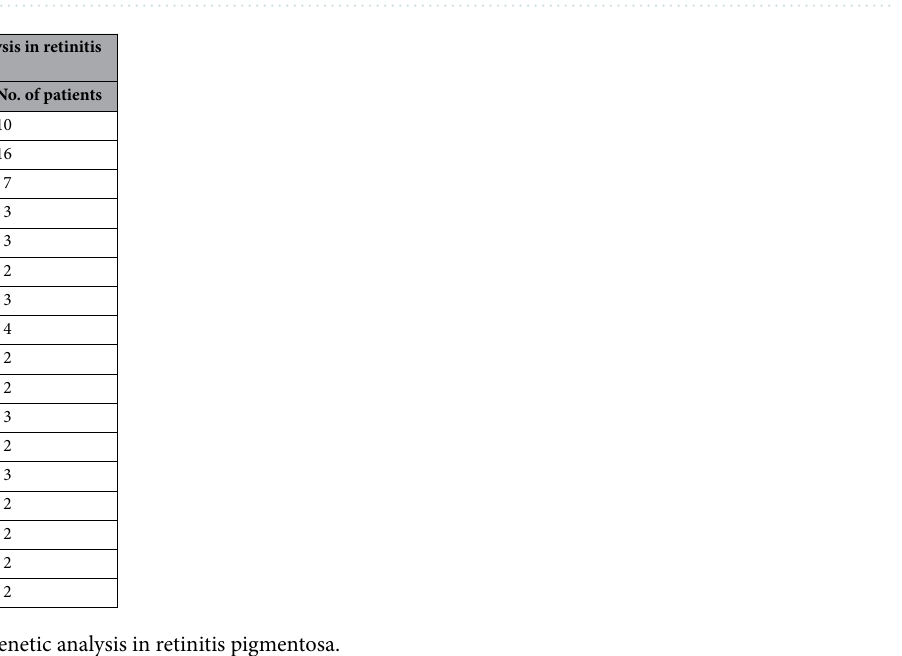
Figure 1. Quantitative analysis scheme. Starting from the original OCT and OCTA data, we obtained the thickness measurements of the choroidal layers by considering five fixed samplings, subfoveal, at 750 µm (right– left) and at 1500 µm (right–left) (upper left part of the scheme). Choroidal vascularity index was calculated after the segmentation and the binarization of the choroid (upper central part of the scheme). Moreover, we used the automatic ETDRS-9 sector grid measurements of retinal layers (upper right part of the scheme). With respect to OCTA, we obtained the enface reconstructions of vascular plexa (lower central part of the scheme). After the binarization of the images and the exclusion of the FAZ area, we calculated vessel density metric (lower left part of the scheme). In addition, choriocapillaris porosity was calculated after the careful detection of the choriocapillaris flow voids (highlighted in red) (lower right part of the scheme).